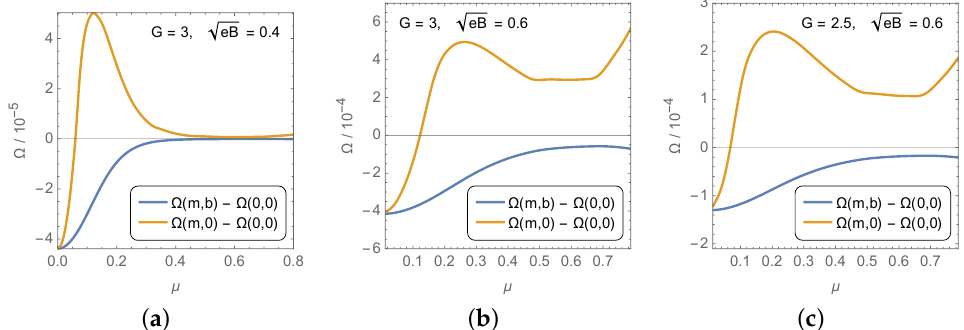
Figure 3. Comparison of free-energies for two phases at subcritical couplings: a homogeneous phase with a magnetically catalyzed condensate (yellow line) and a spatially inhomogeneous phase (blue line) with an MDCDW